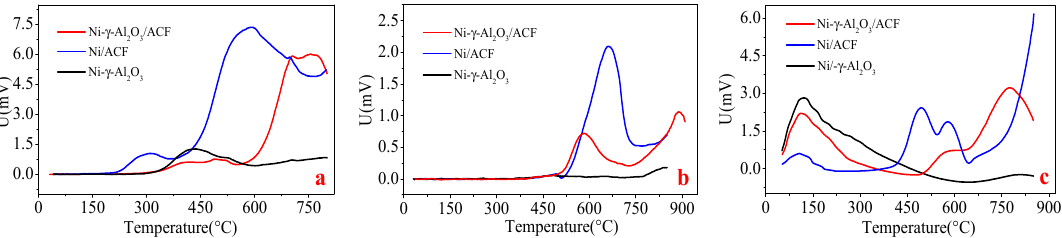
Figure 2. Chemisorption characterizations for different catalysts ( a ) H 2 -temperature programmed reduction (H 2 -TPR); ( b ) H 2 -temperature programmed desorption (H 2 -TPD); ( c ) CO 2 -temperature programmed desorption (CO 2 -TPD).